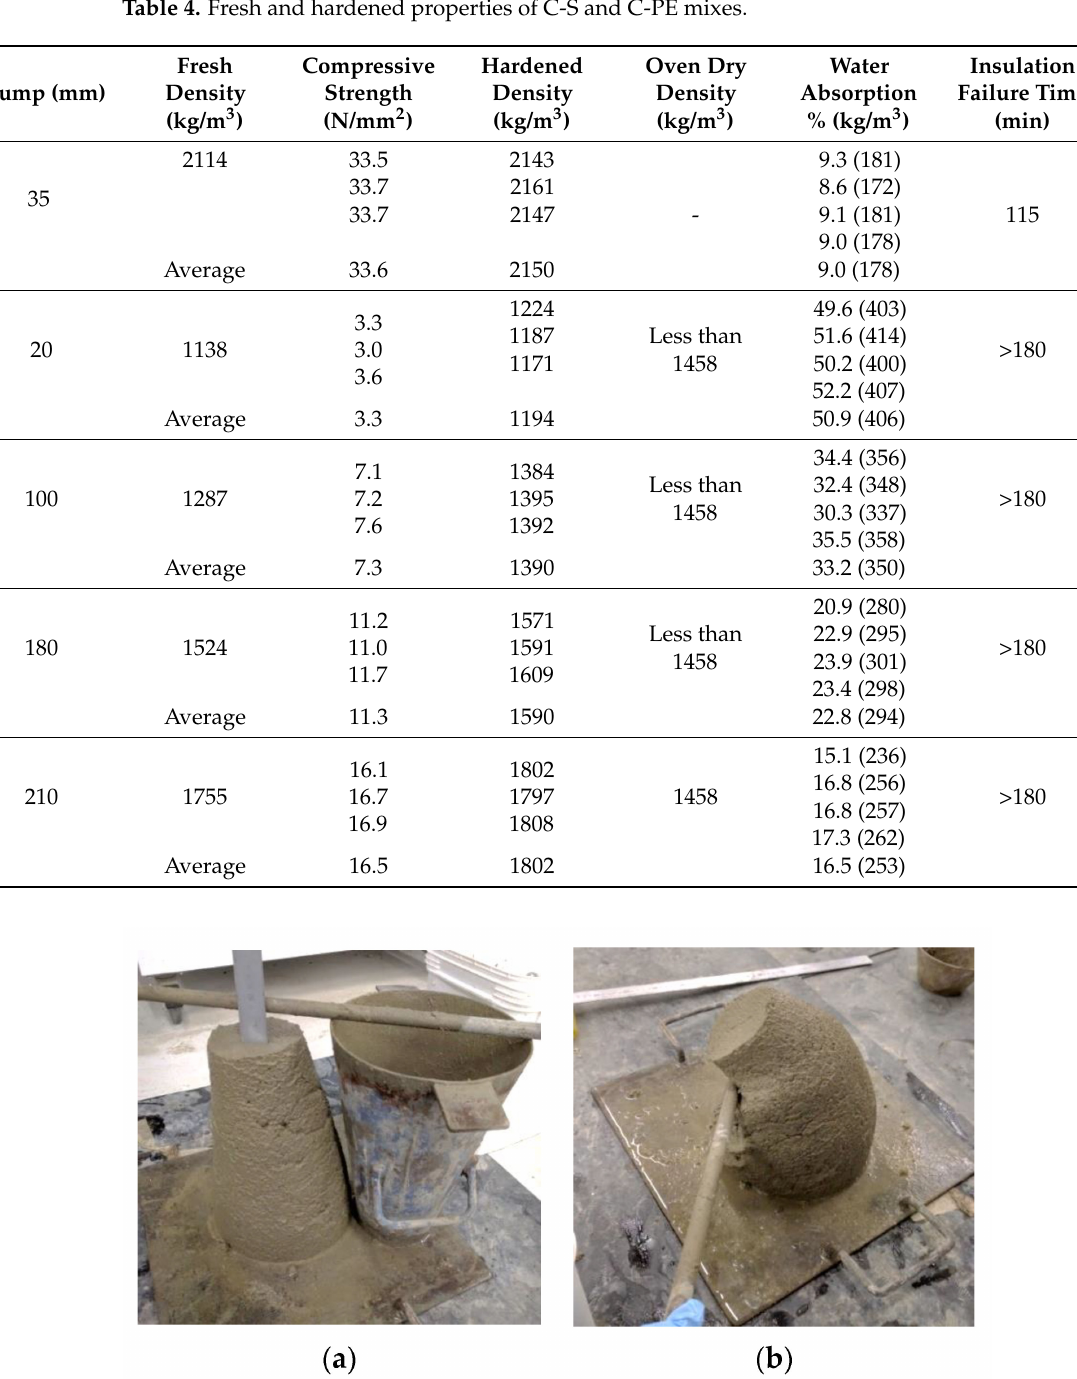
Figure 11. Slump test of the C-S mix: ( a ) shape of the slump and ( b ) gradual movement of the